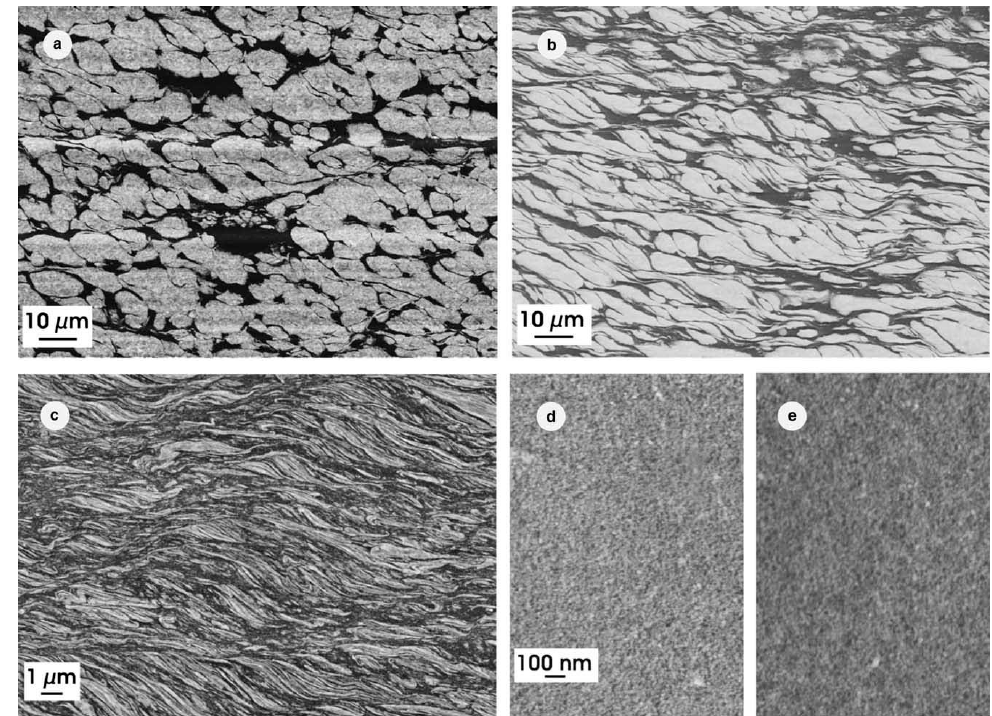
Figure 5. The microstructure of the W–25%Cu composite subjected to HPT at room temperature to strains ε of: ( a ) 4; ( b ) 16; ( c ) 64; ( d ) 256; ( e ) 512. Reprinted with permission from ref. [79]. Copyright 2005 Elsevier.